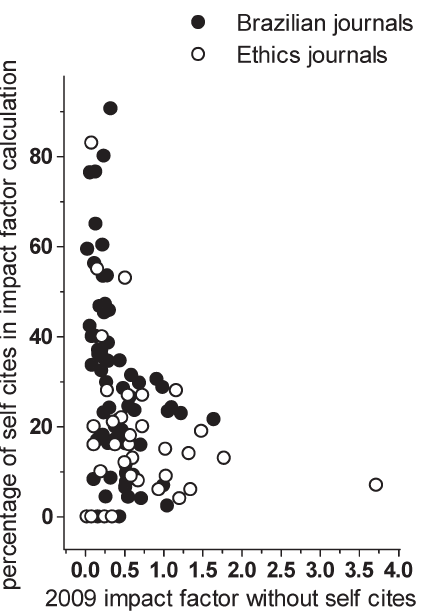
Figure 3 - Impact factors calculated without self-cites versus the percentage of self-cites used for impact factor calculation. A significant negative correlation was only observed for Brazilian journals (r=-0.527; p , 0.0001; Spearman rank order correlation) but not for